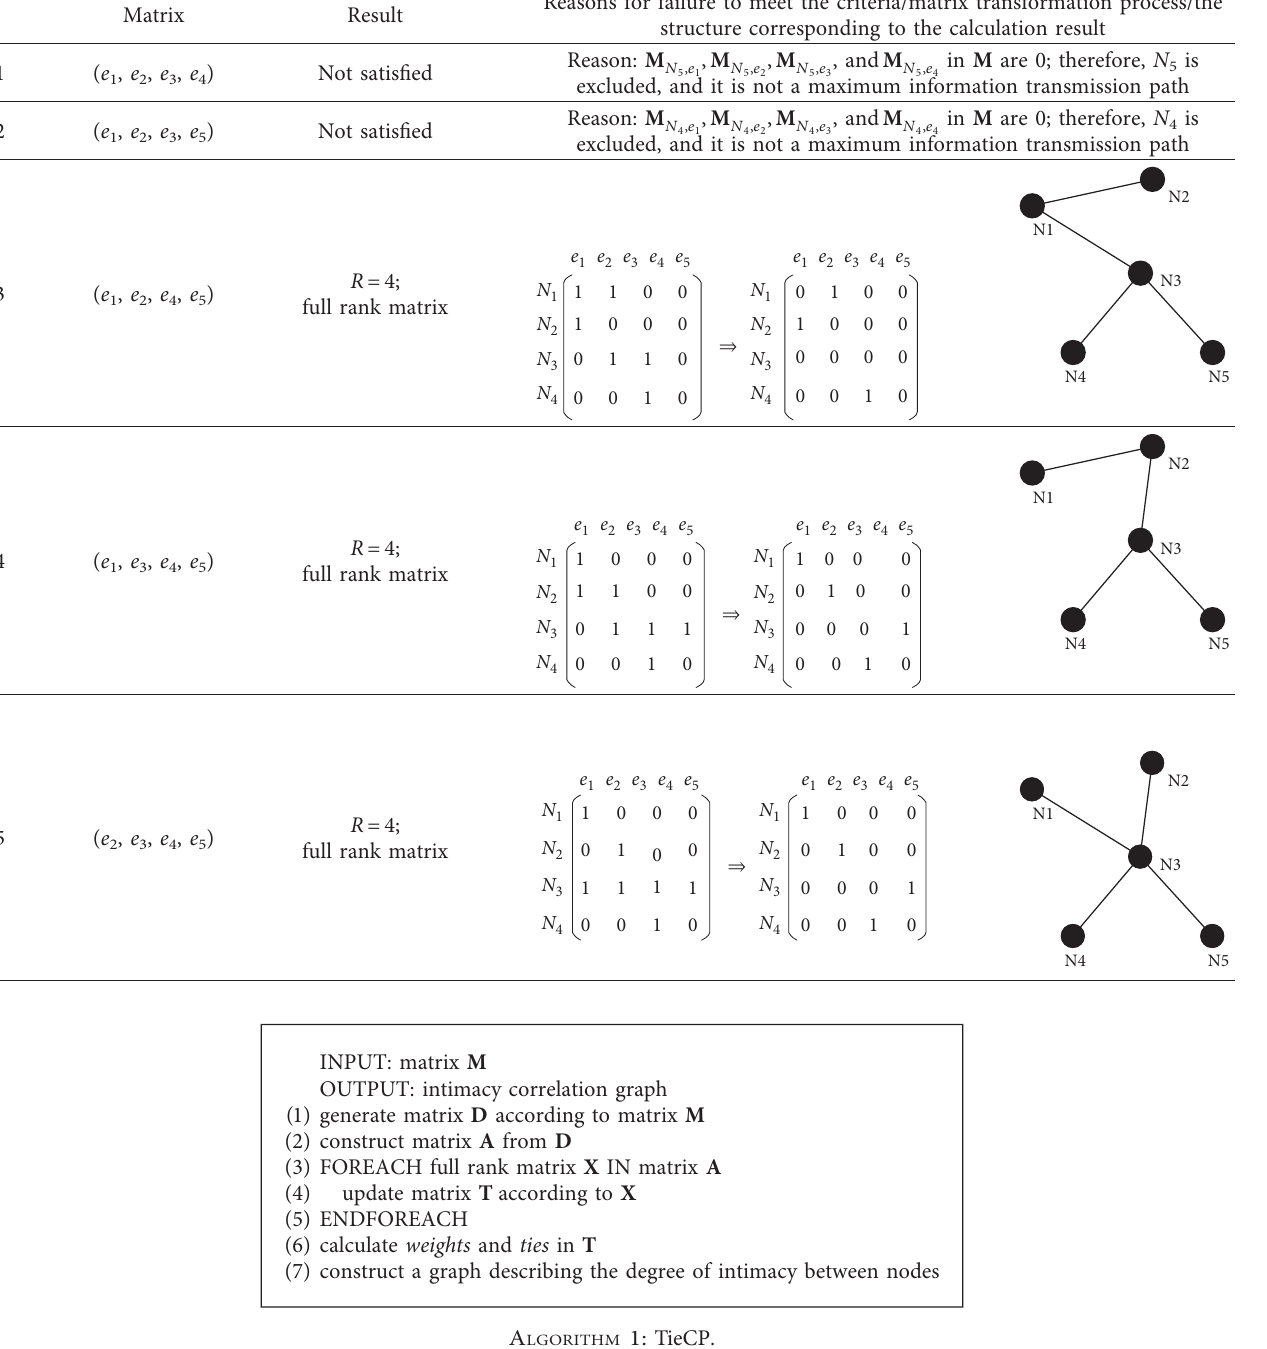
Table 1: The process of mining maximum information transmission paths. Reasons for failure to meet the criteria/matrix transformation Matrix